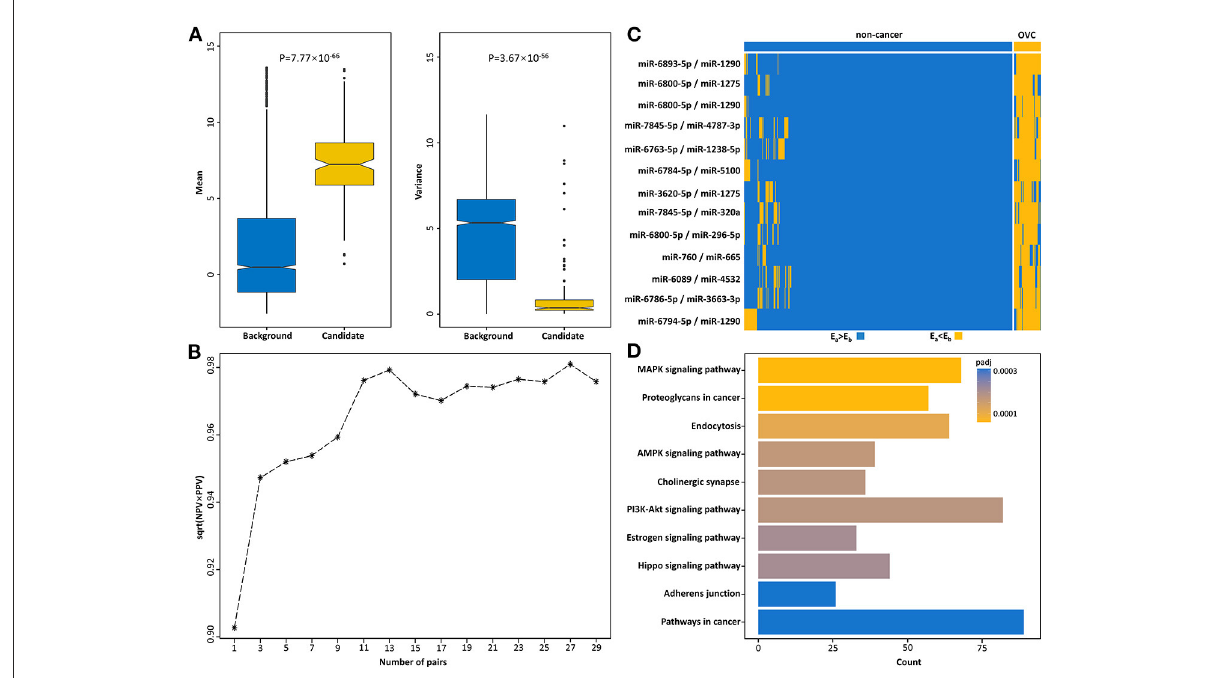
FIGURE3 Identification of serum diagnostic miRNA pairs for OVC. (A) Boxplots of mean and variance of expression of miRNAs in background and candidate diagnostic miRNA pairs. (B) The square root of PPV and NPV of candidate top miRNA pairs for diagnosing OVC in the training set. (C) The corresponding REOs of 13-miRPairs. (D) The 13-miRPairs associated KEGG